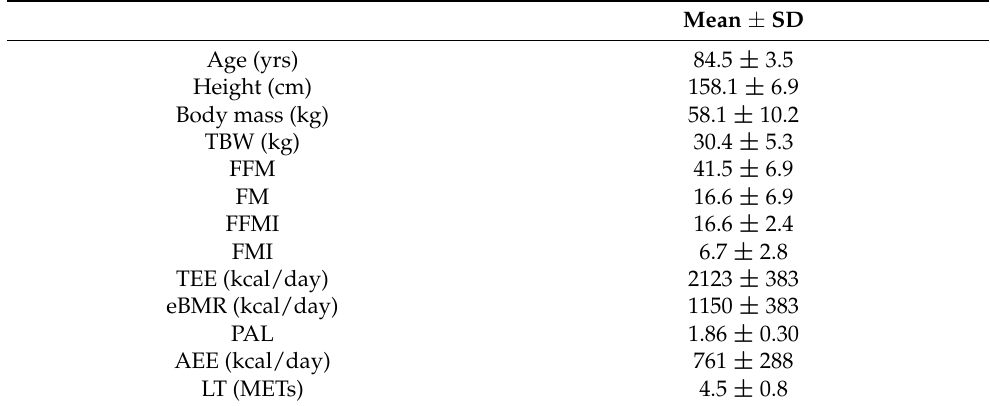
Table 1. Physical characteristics, body composition, energy expenditure, physical activity, and aerobic capacity of the participants.